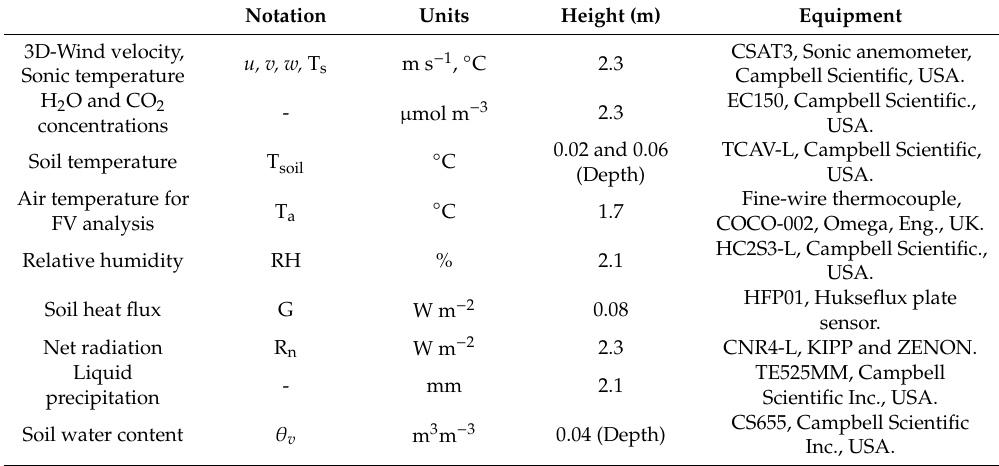
Table 3. List of sensors, units, measurement height and equipment used in the